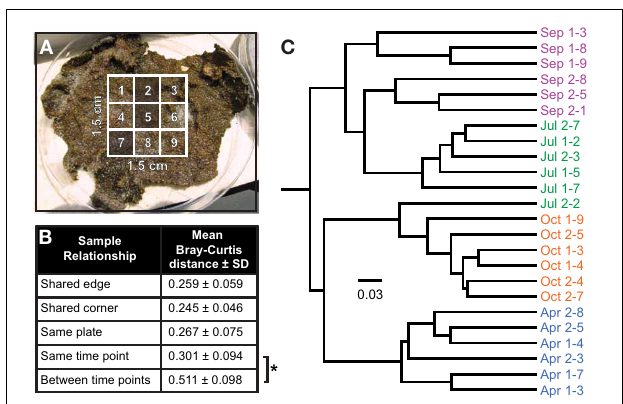
FIGURE 5 | Inter-sample variability in community structure. (A) Random sampling strategy. A grid comprising nine subsamples, each 5mm on a side and encompassing the entire depth of the mat (usually 3–5mm), was cut into the center of each mat sample, three of which were selected for sequencing per plate using a random number generator. Two plates containing independent mat samples were subsampled at each time point. (B) Mean Bray-Curtis distance as a function of the relationship between two samples. No significant difference in mean Bray-Curtis distance, as determined by unpaired Student’s t -test assuming unequal variance, was detected between samples that share an edge (e.g., sample 2 and 5 in panel A ) or corner (e.g., sample 5 and 7), or non-contiguous samples from the same plate (e.g., sample 2 and 7) or on different plates collected at the same sampling time point. A significant difference was observed between samples collected at the same time point and those collected at other time points (as denoted by the asterisk, p < 1 × 10 − 26 ). (C) Neighbor-joining tree of Bray-Curtis β -diversity by